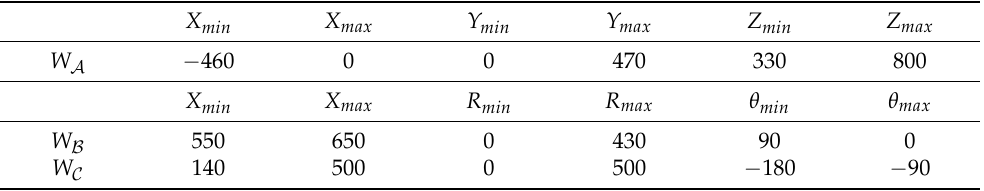
Table 3. Boundaries of the Workspaces with respect to the origin O . Dimensions in mm and angles in deg